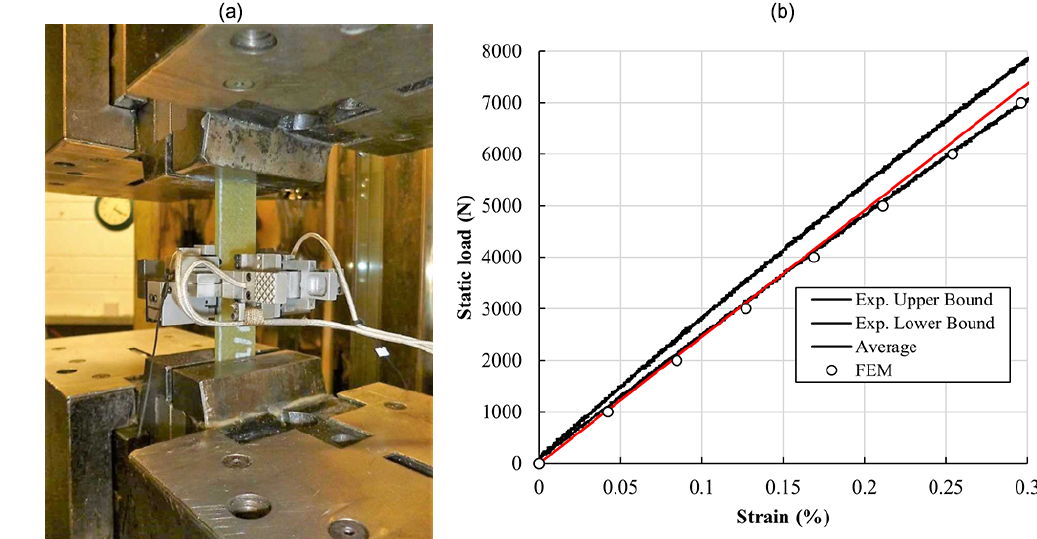
Figure 2. Experimental static testing of glass-fibre reinforced specimens, where (a) is the tests being performed and (b) is a comparison of the experimental static testing results with the results from the FEA model.